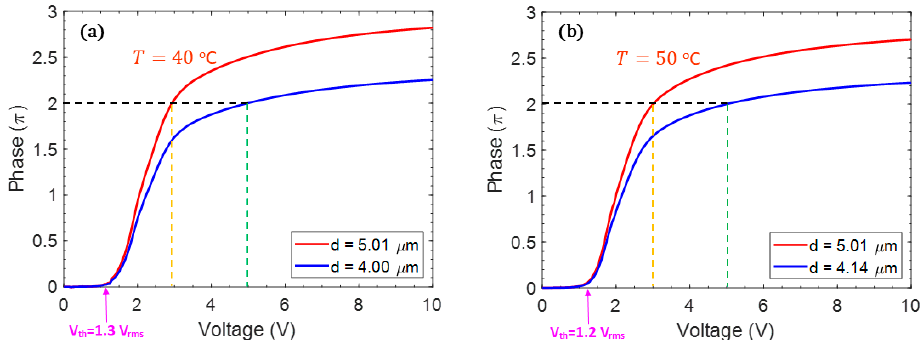
Figure 5. Measured (red line) voltage-dependent phase change of a transmissive UCF-216 test cell at λ = 633 nm and 1 kHz. Cell gap is d = 5.01 µ m, with V 2 π = 2.9 V rms at T = 40 ◦ C in ( a ) and with V 2 π = 3 V rms at T = 50 ◦ C in ( b ). If we allow V 2 π = 5.0 V rms , then we can reduce the cell gap to 4.14 µ m (blue line in ( b )), which is equivalent to 2.07 µ m in a reflective LCoS